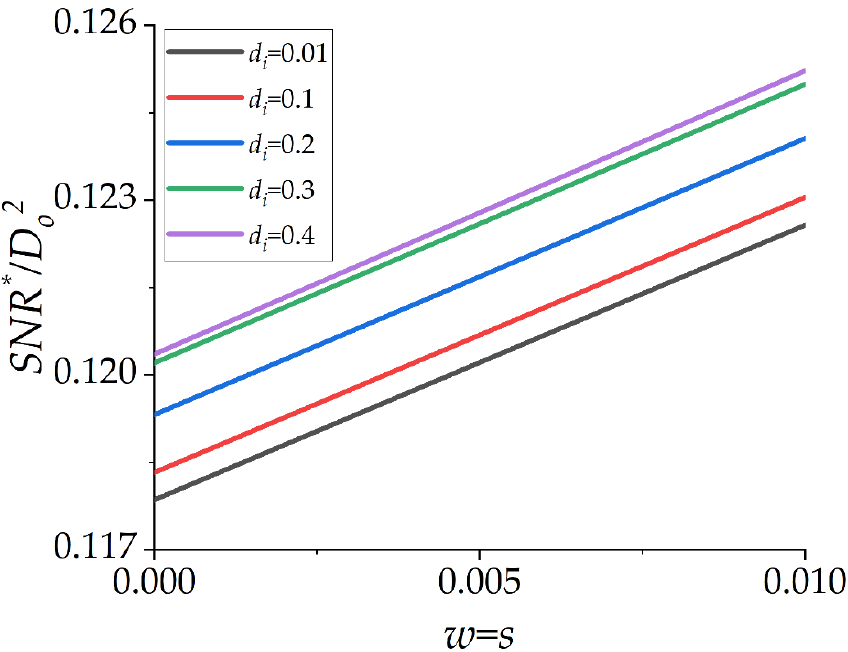
Figure 3. SNR* /D o2 as a function of the normalized track width w (= s ) for different normalized inner diameters ( d i ). The value of SNR*/D o2 changes slightly, while w and s are identical and change sim- ultaneously.